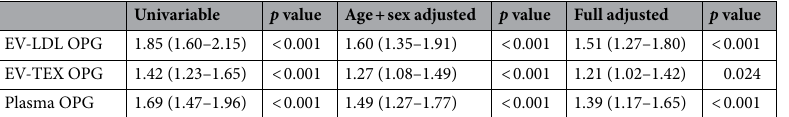
Table 3. Ordered regression analysis of OPG levels and categorical CAC scores. Full adjusted model included: age, sex, smoking, hypertension, diabetes mellitus and a previous history of coronary artery disease. Outcome variable was categorized in five classes: 0; 1–99; 100–399; 400–999 and > 1000. EV extracellular vesicle, EV-LDL and EV-TEX different subpopulations of EVs.